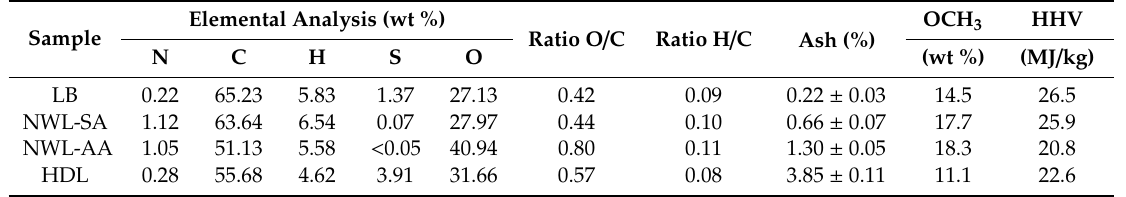
Table 3. Elemental composition of lignin samples with the ash content and higher heating values.